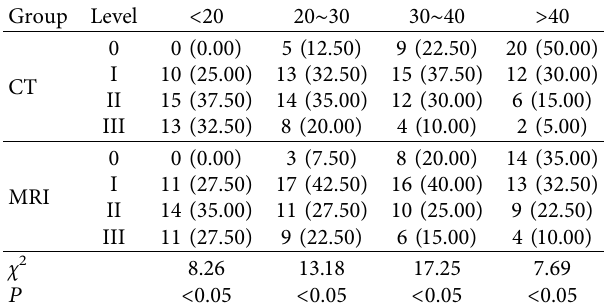
Figure 7: Compatibility and recovery rate at different recovery stages for different methods. Table 3: Comparison of assessment results of different imaging methods on the exercise rehabilitation therapies of the three groups of